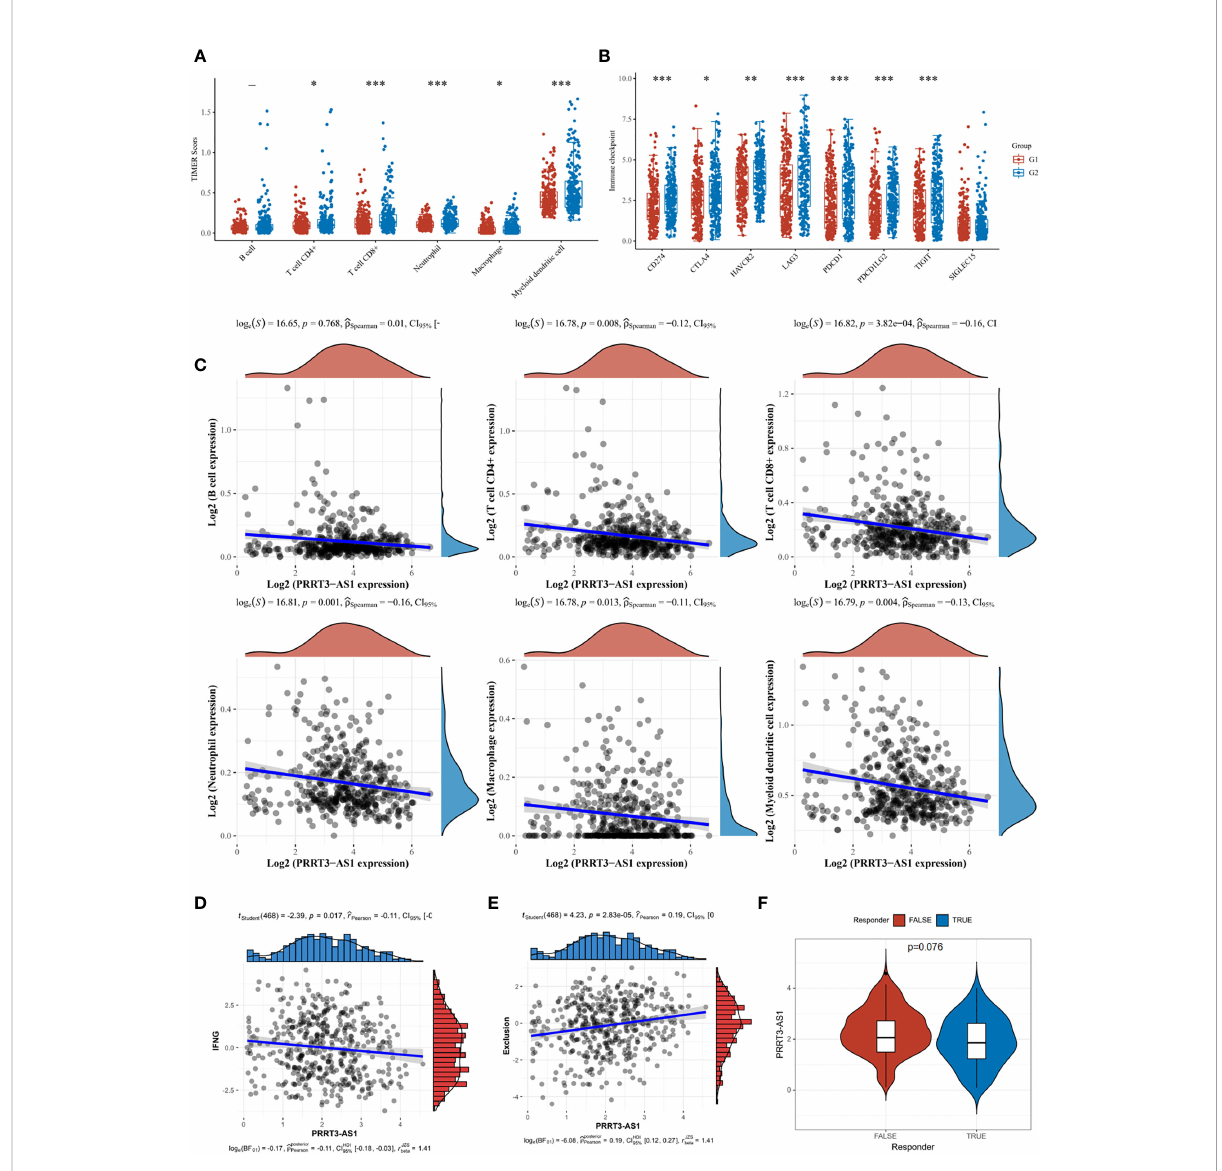
FIGURE 7 Immune cell in fi ltration landscape of PRRT3-AS1 in TCGA-SKCM. (A) Level of immune cell in fi ltration comparing PRRT3-AS1 high group and PRRT3-AS1 low group. (B) Level of immune checkpoint comparing PRRT3-AS1 high group and PRRT3-AS1 low group. (C) The distribution of B cell, CD4+ T cell, CD8+ T cell, neutrophil, macrophage, myeloid dendritic cell count, and the expression level of PRRT3-AS1. (D) The co- expression of interferon-gamma (IFNG) and PRRT3-AS1. (E) The co-expression of immune exclusion score and PRRT3-AS1. (F) PRRT3-AS1 expression in the immunotherapy response group and immunotherapy non-response group. * P < 0.05, ** P < 0.01, *** P <